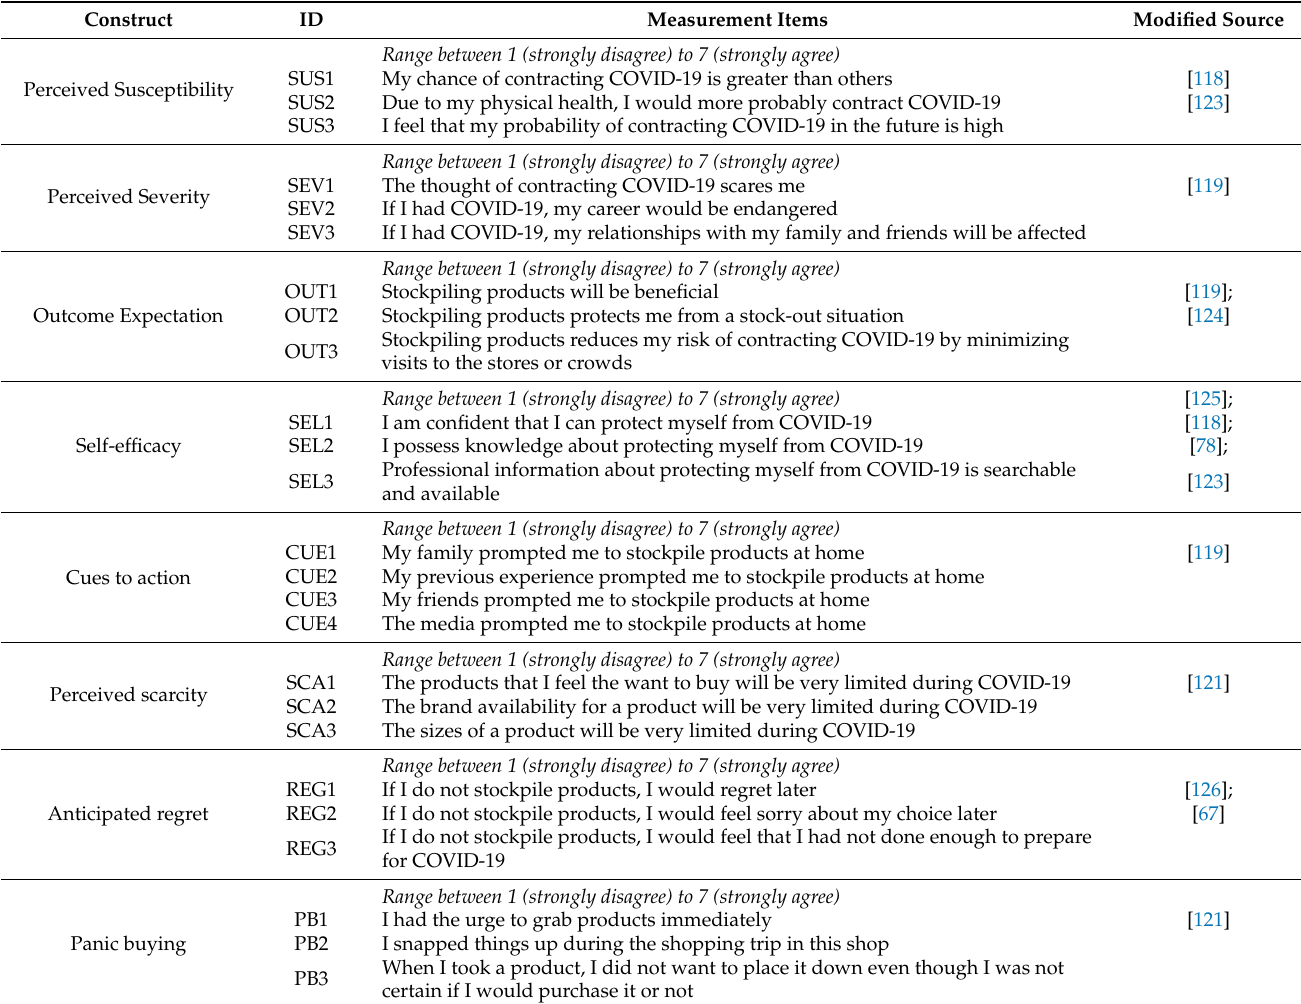
Table 2. Measurement items and